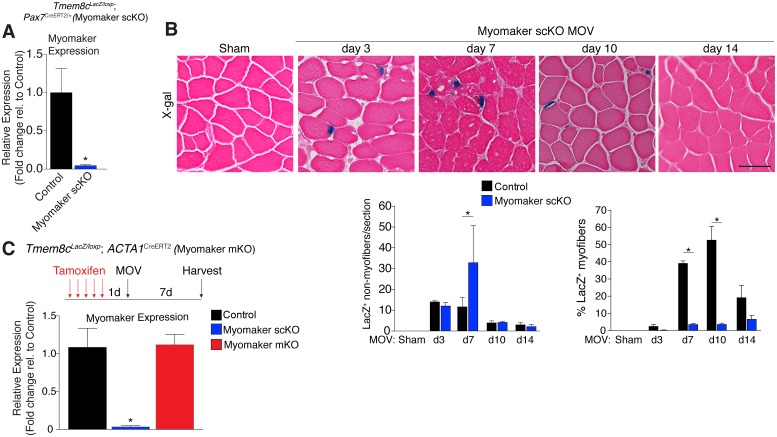
Myomaker is mainly expressed in MPs and not myofibers during MOV.(A) Tmem8cLacZ/loxP; Pax7CreERT2/+ mice (myomaker scKO) were treated with tamoxifen to ablate myomaker specifically in SCs. Control mice include vehicle-treated Tmem8cLacZ/loxP; Pax7CreERT2/+ mice and tamoxifen-treated Tmem8c+/+; Pax7CreERT2/+ mice. Mice were subjected to MOV and myomaker expression was assessed through qPCR analysis 7 days post-surgery showing that myomaker was efficiently deleted in myomaker scKO muscle (n = 3–4 independent mice). (B) To determine the origin of LacZ staining observed in control myofibers (Figure 1C), MOV was performed on myomaker scKO mice and sections were X-gal stained. Ablation of myomaker in SCs results in restriction of myomaker expression to MPs and lack of expression in the myofiber. Quantification of LacZ+ non-myofibers shows a significant increase at day 7 in myomaker scKO mice compared to control mice because myomaker scKO are fusion defective and thus remain outside the myofiber (n = 3–5 mice). The percentage of LacZ+ myofibers are reduced in myomakerscKO mice suggesting that myofiber LacZ is acquired through fusion of MPs (n = 2500–4,100 myofibers from 3–5 independent mice). In the quantification of (B), the control bars are from Figure 1C. (C) To genetically assess the requirement of myofiber-derived myomaker, tamoxifen was administered to Tmem8cLacZ/loxP; ACTA1CreERT2 mice (myomaker mKO) prior to MOV. qPCR analysis of myomaker in control, myomaker scKO, and myomaker mKO mice after MOV shows that myomaker is only reduced in myomaker scKO mice, demonstrating that myomaker is not transcribed from a myofiber nucleus (n = 3–4 mice). Data are represented as mean ± SEM, *p<0.05. Scale bar: 50 μm.